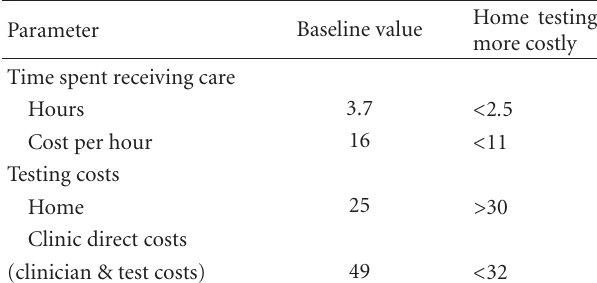
Table 4: One-way sensitivity analysis, all subjects and all testing. Parameter values where the home testing intervention is more costly than clinic-based